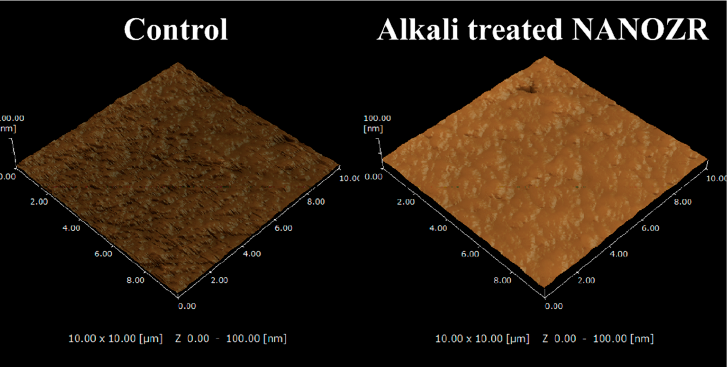
Figure 2. Scanning probe (SP) micrographs of control and test groups.